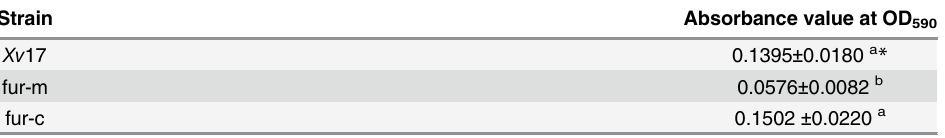
Table 3. Quantitative measurement of biofilm formation as indicated by absorbance at OD 590 in Xv .